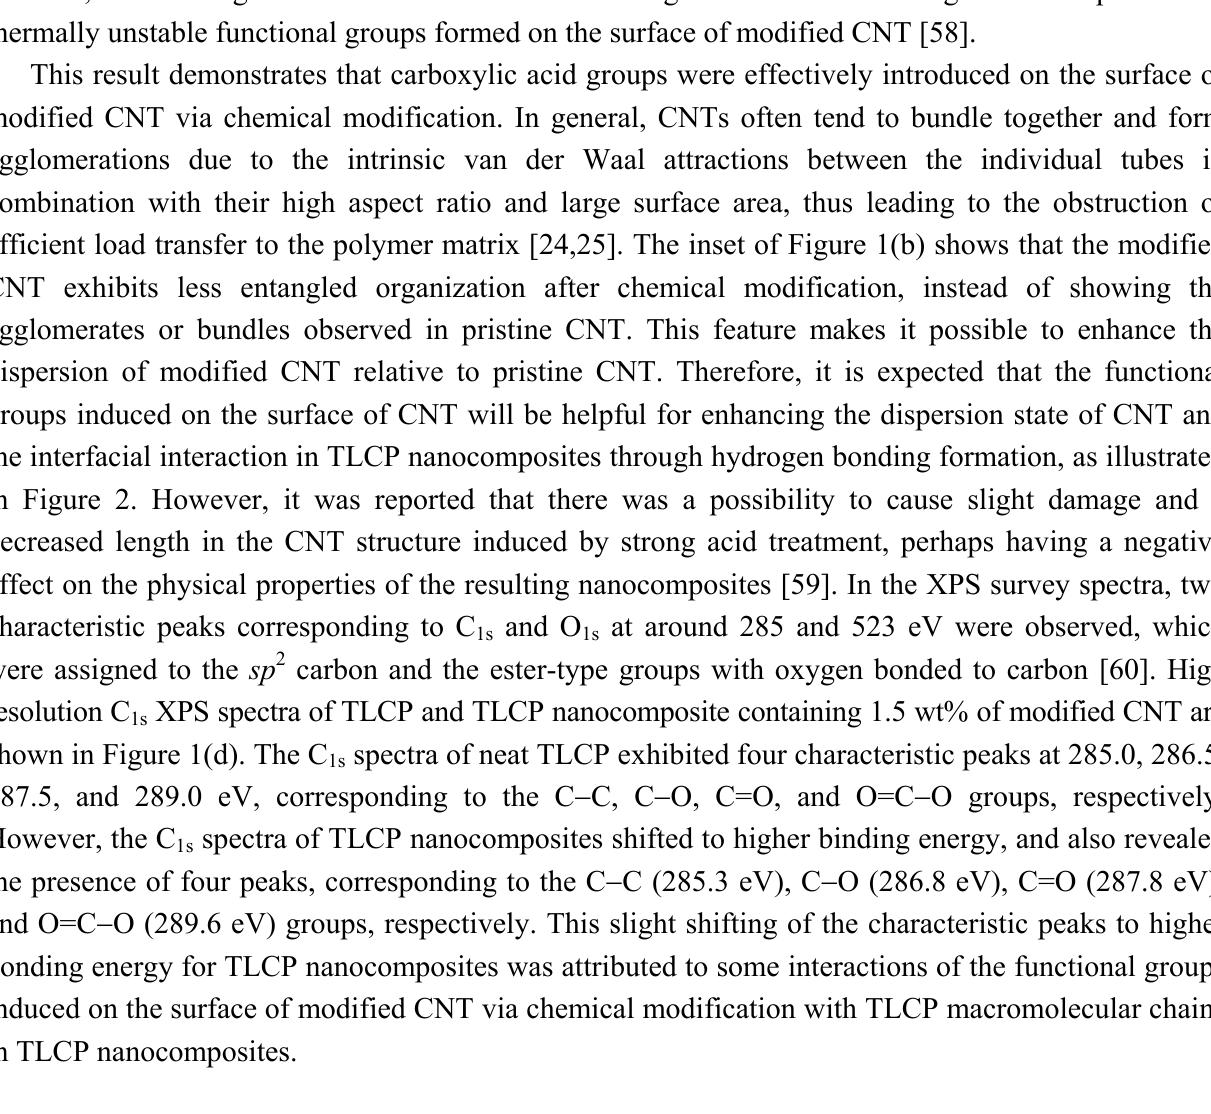
Figure 2. Schematic of possible interactions between modified CNT and TLCP though hydrogen bond